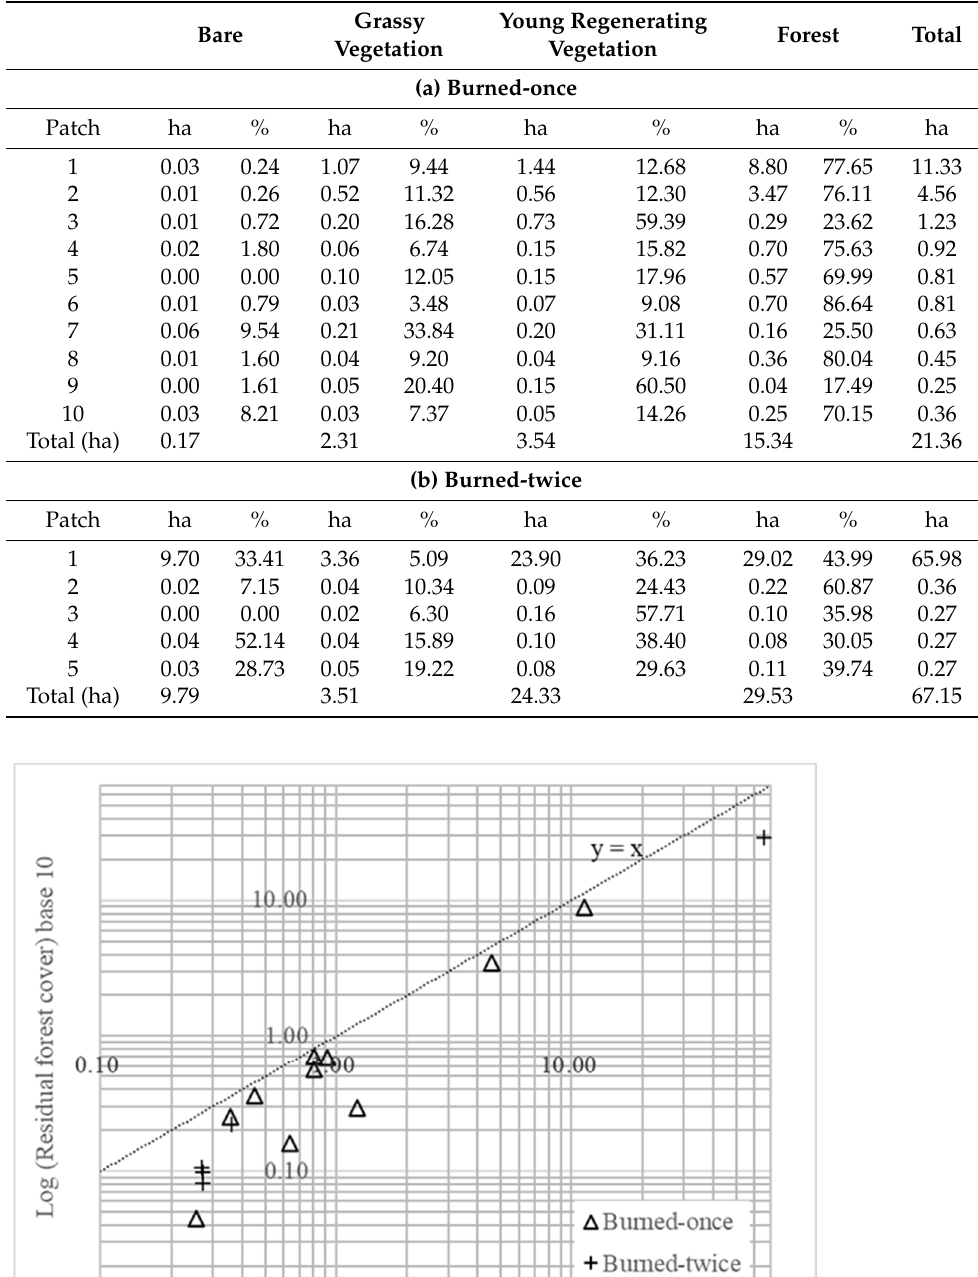
Table 2. Land cover statistics of patches of different fire frequencies.